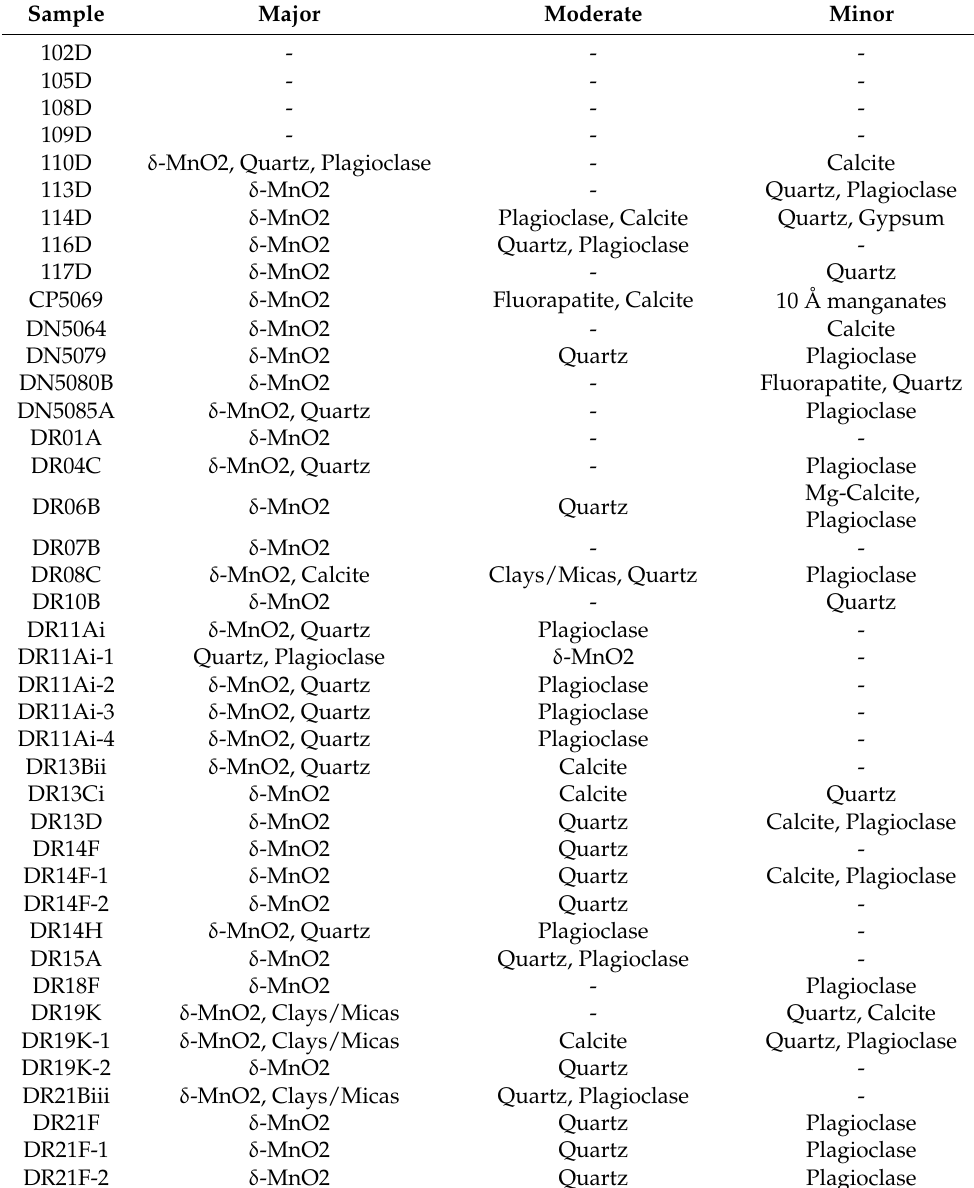
Table 2. XRD and SEM mineralogy of ferromanganese deposits ( n = 104) from New Caledonia.